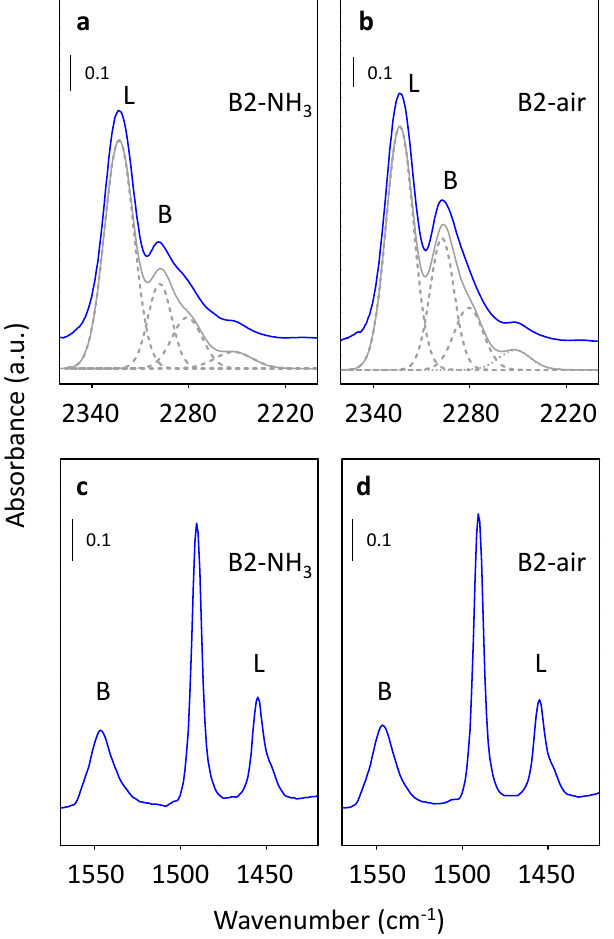
Figure 8. FTIR spectra of adsorbed d 3 -acetonitrile for dehydrated H-forms of calcined in ammonia ( a ) and air ( b ) B2 sample together with deconvolution of the spectra (gray lines) and after adsorption of pyridine ( c , d ).